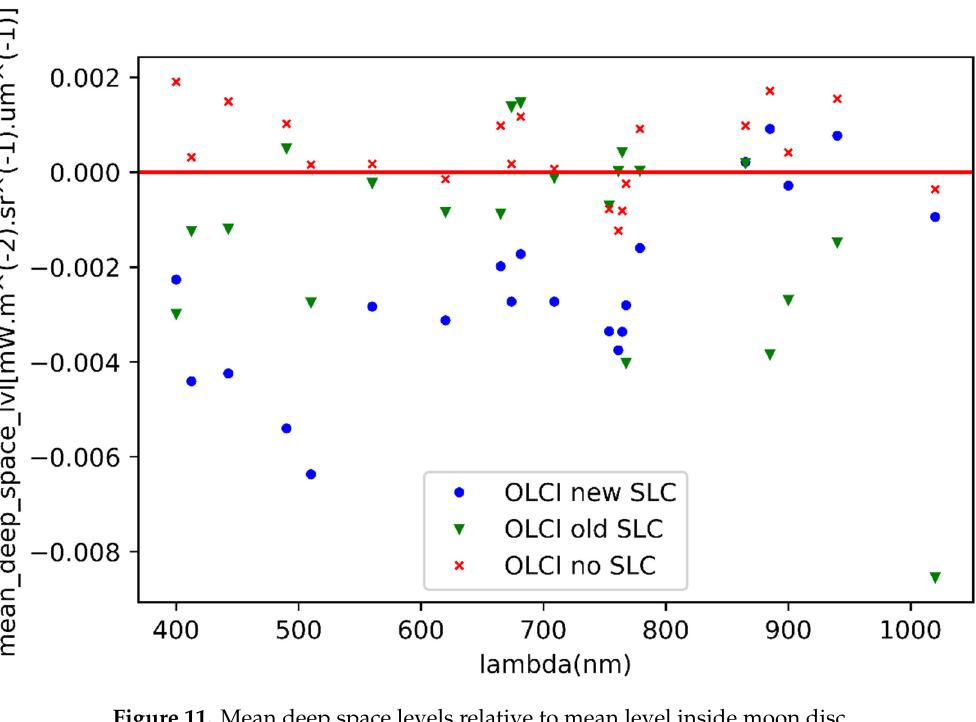
Figure 11. Mean deep space levels relative to mean level inside moon disc.